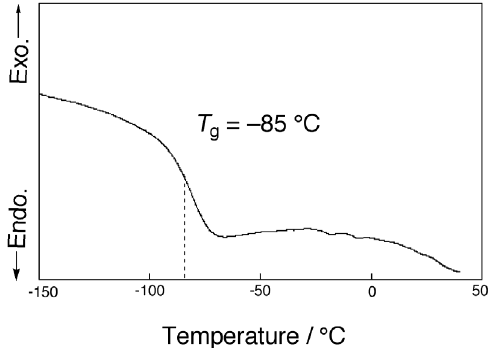
Figure 2. DSC thermograph of PC18AAm (Heating rate, 10 °C·min − 1 ; N 50 cm 3 ·min − 1